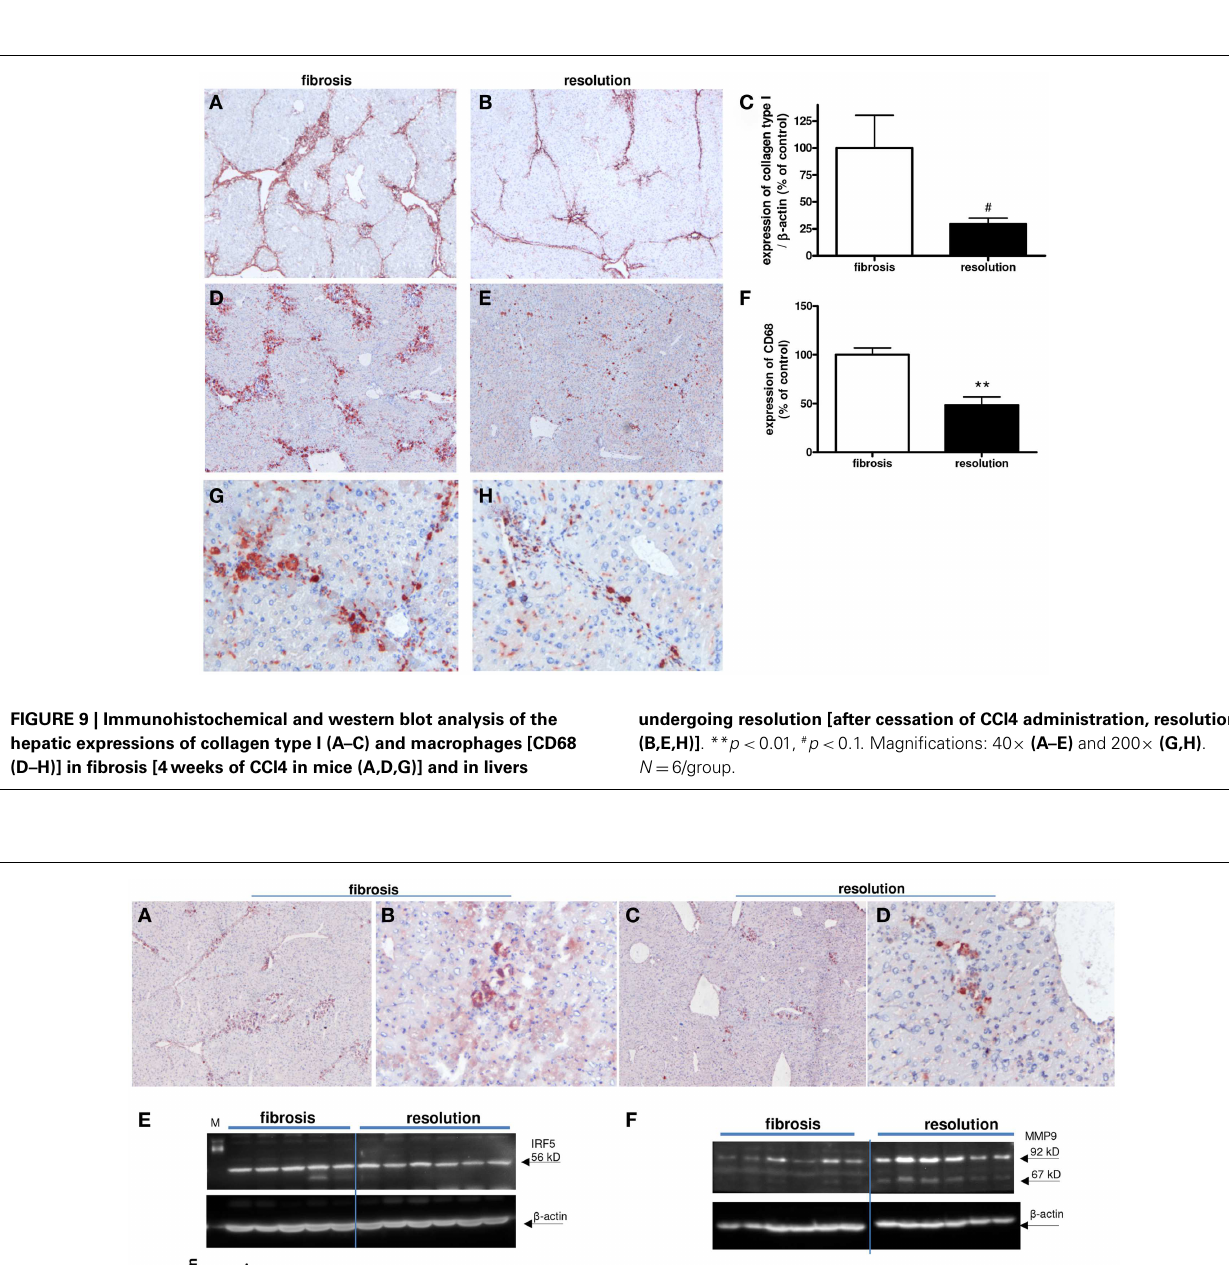
FIGURE 10 | Expressions of IRF-5 and MMP9 (M1) in fibrotic mouse livers [4weeks CCl4 (A,B)] and in fibrotic livers undergoing resolution [after cessation of 4weeks of CCl4 administration (C,D)] . Immunohistochemical pictures demonstrate an overview [ (A,C) magnification 40 × ] and close up [ (B,D) magnification 200 × ]. (E) Western blot quantification of hepatic IRF-5